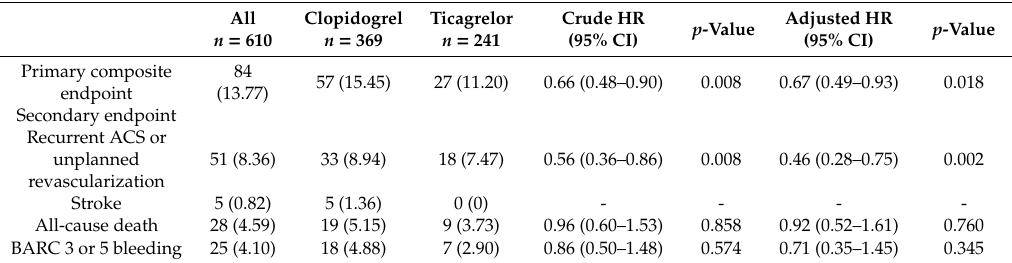
Figure 1. Subgroup analysis of the effect of clopidogrel versus ticagrelor on primary composite endpoint.